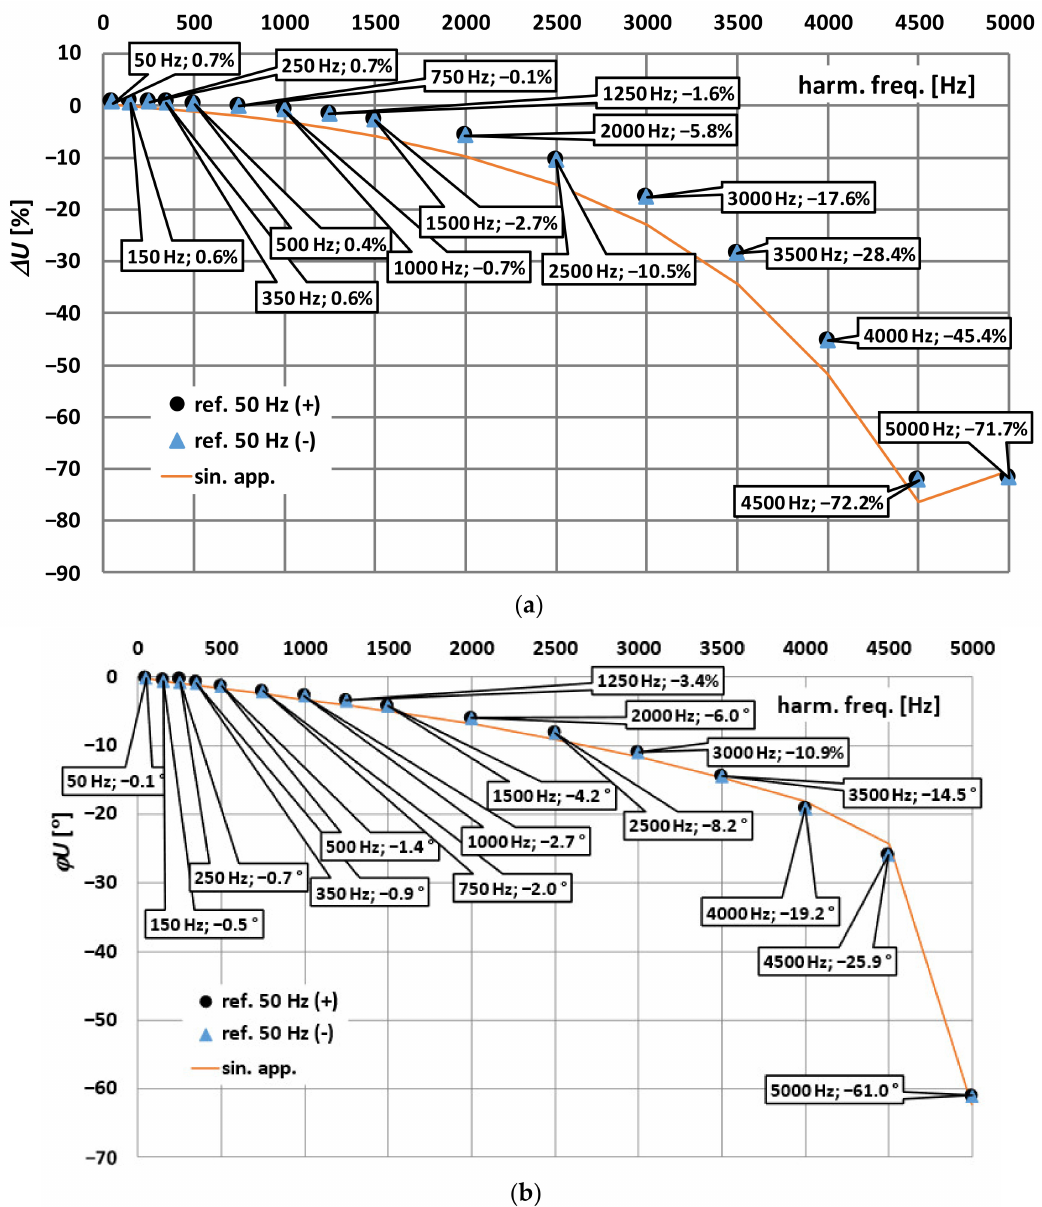
√ 3) kV VT for harmonics of the non-sinusoidal and